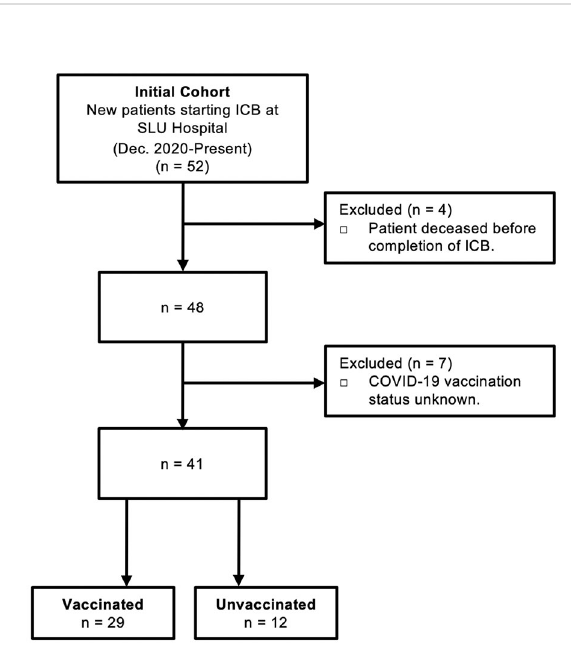
FIGURE 1 Criteria for study inclusion. Consolidated Standard of Reporting Trials (CONSORT) diagram describing the selection of COVID-19 vaccinated patients and control unvaccinated patients that received immune checkpoint blockade (ICB) immunotherapy for cancer at Saint Louis University (SLU) Hospital from December 2020 to